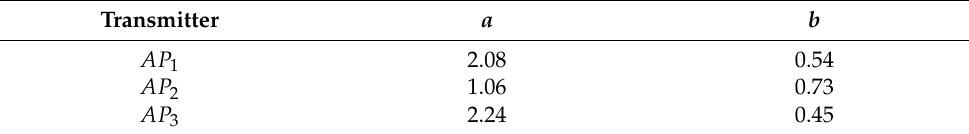
Table 7. The solved coefficients of error correction linear regression equation.